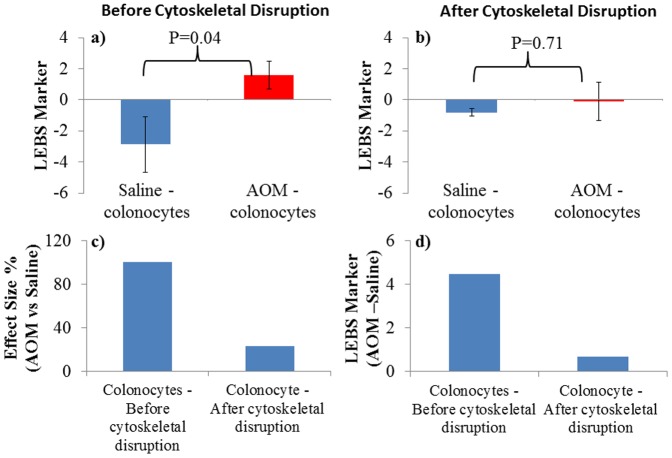
Structural Changes from colon cells are primarily from aberrant cytoskeleton.
a,b) The graphs show the difference in LEBS markers for colonocytes from Saline-treated and AOM-treated rats, before and after cytoskeletal disruption. AOM treatment significantly altered (p<0.05) the LEBS marker compared to saline-treated controls. Disruption of the cytoskeletal assembly with colchicine nullified this difference (p = 0.71) c,d) The effect size and delta between LEBS markers from saline-treated and AOM-treated rat colonocytes are higher before cytoskeletal disruption. The difference in structure measured by the LEBS marker between saline-treated and AOM-treated rat colonocytes was negated by disruption of the cytoskeleton, suggesting that the cytoskeleton plays a role in determining or signaling intracellular changes in early carcinogenesis.